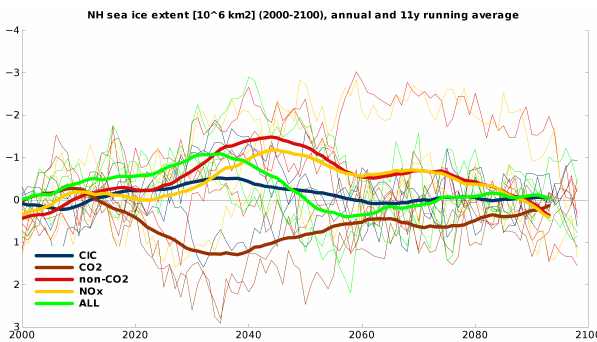
Fig. 14. Time series of the aviation emissions impacts on the north- ern hemispheric sea-ice area in September between 2000 and 2100. Thin lines indicate the annual impact of each of the three members of a simulation, and the thick lines indicate the 11-yr running aver- age of the ensemble mean. The blue, brown, red, yellow and green lines correspond to the CIC, CO 2 , non-CO 2 and NO x impacts, and the Total aviation impact,